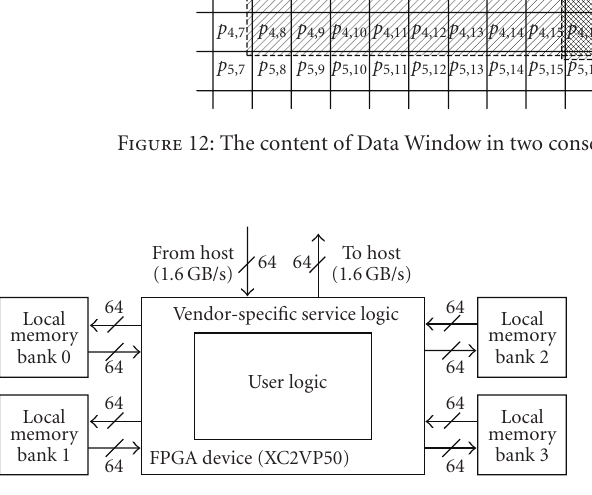
Figure 13: Cray XD1 FPGA local memory